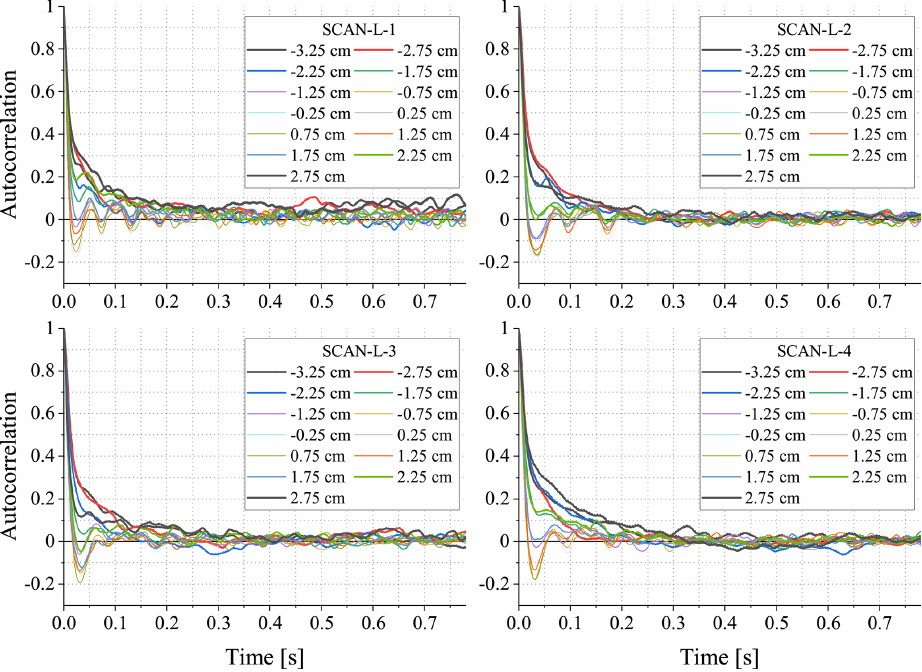
Figure 9. Autocorrelation functions of the time series n(t) recorded at various positions x during the four scans differing in the thermody- namic properties of the input streams (see Table 1 for wind tunnel settings). Thinner lines correspond to the positions close to the centre while thicker lines represent the distant ones.